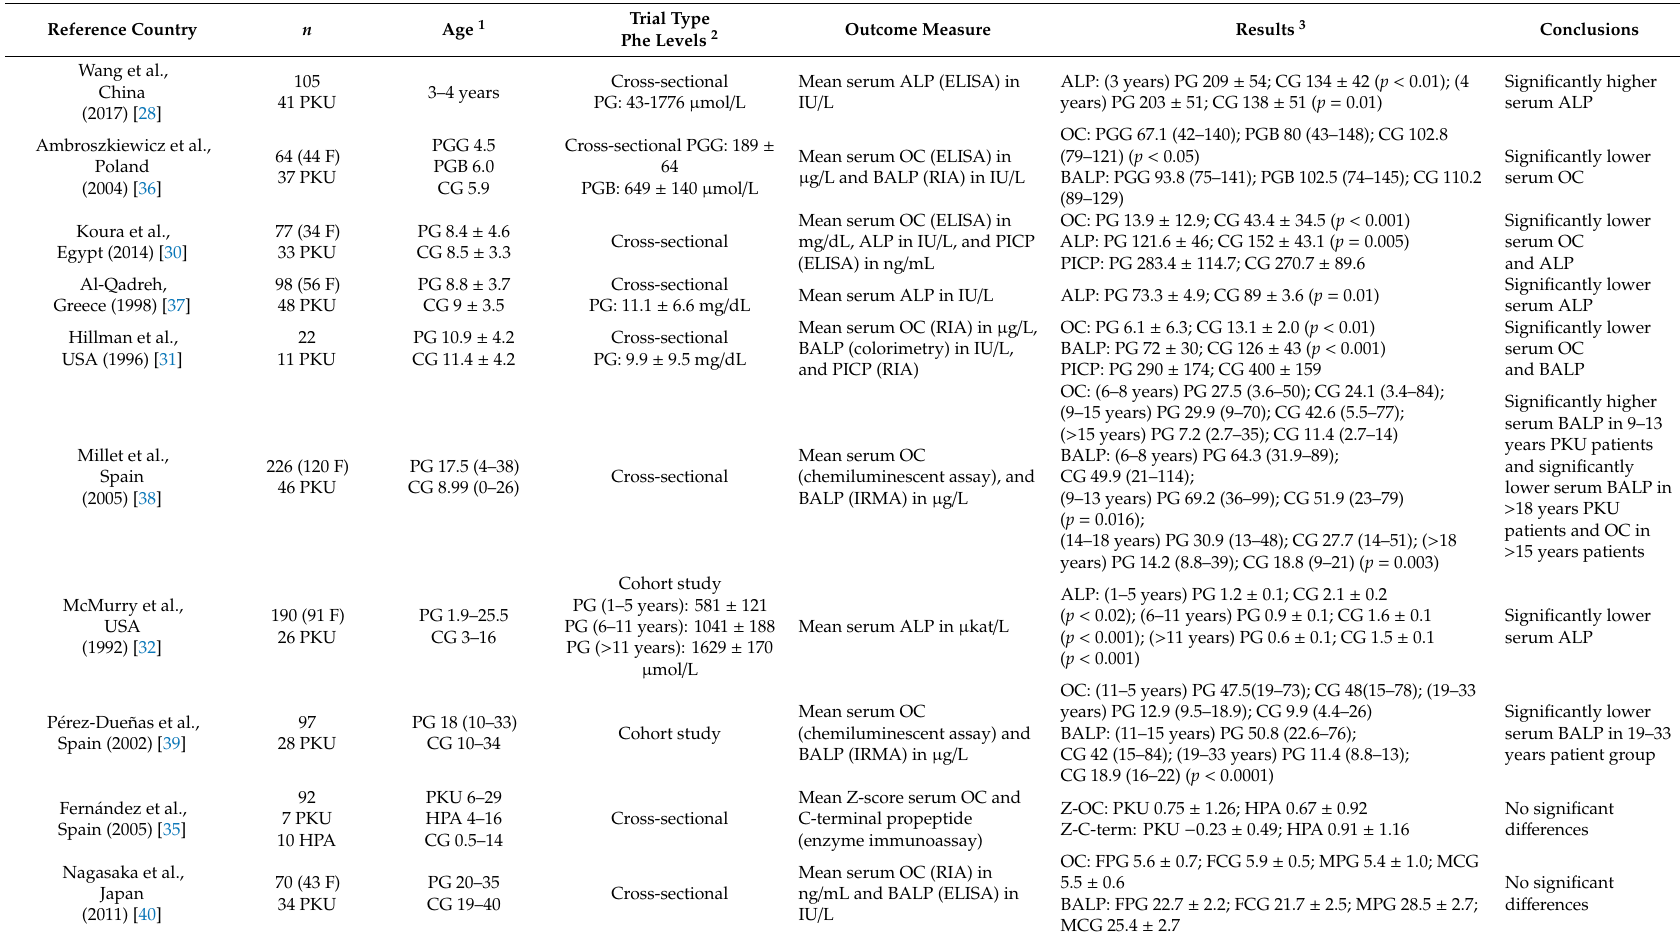
Table 2. Bone formation in patients with